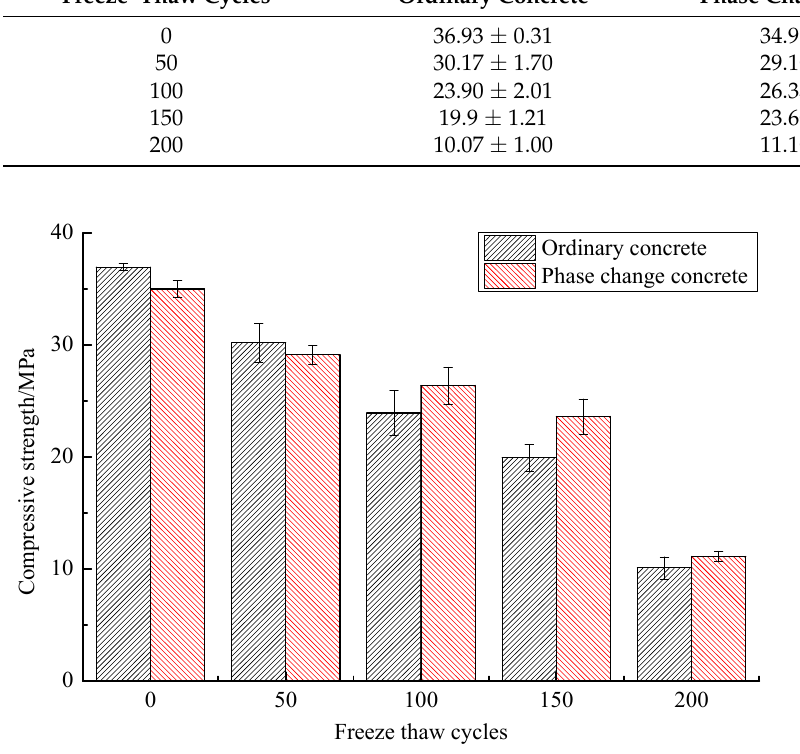
Figure 9. Change of compressive strength during freeze–thaw period. Table 13. Splitting tensile strength of concrete during freeze–thaw (MPa).